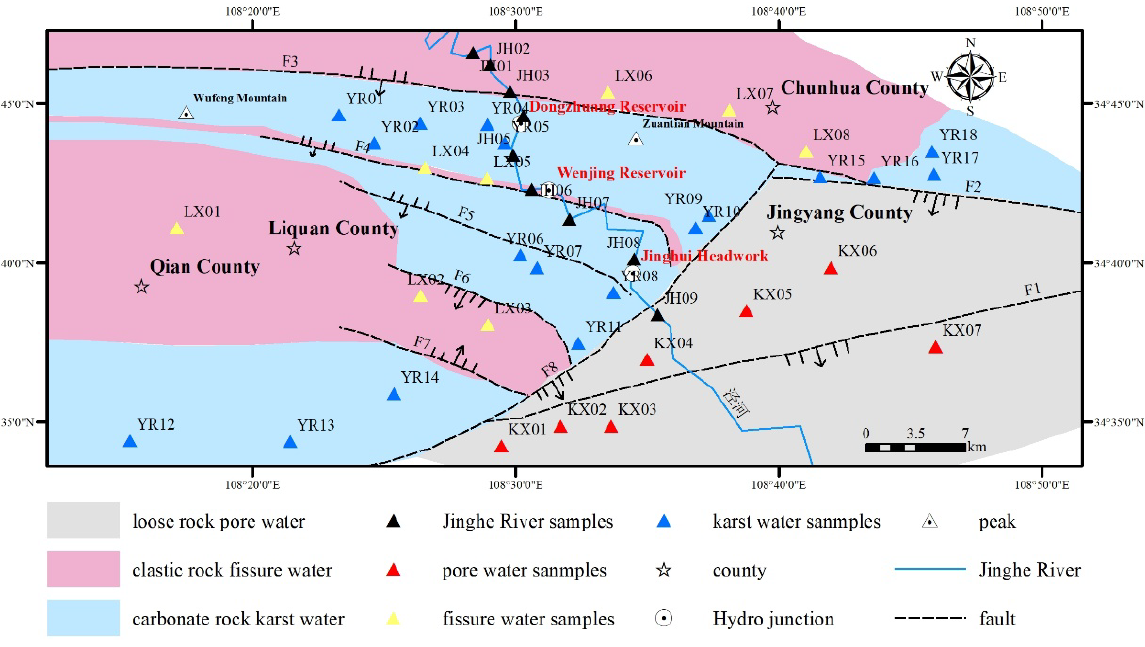
Figure 1. Groundwater types and distribution of sampling points in the study area.